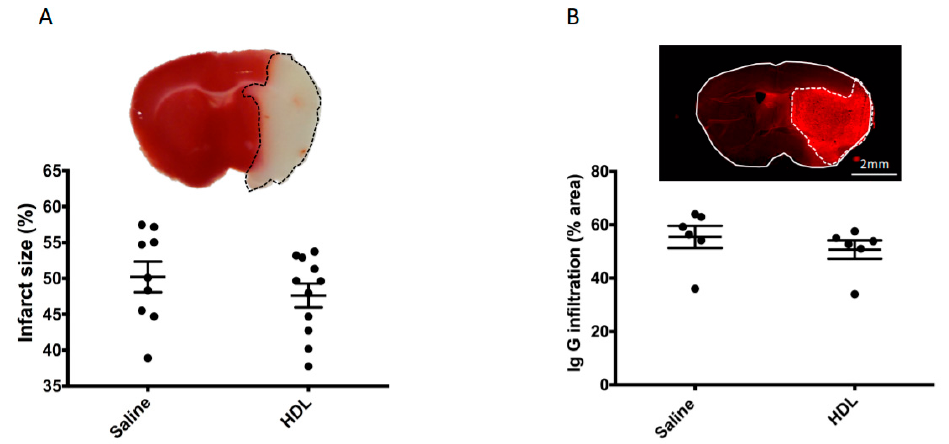
Figure 2. Infarct size and blood–brain barrier leakage. ( A ): Coronal brain sections stained with TTC. The red zone corresponds to the healthy brain region, whereas the white zone represents the infarcted area. No statistical difference was observed between saline- and HDL-treated mice (Saline: n = 9, HDL n = 11). ( B ): Coronal brain sections stained by with an antibody against immunoglobulins G (IgG) (red). The bright red area represents the infiltration of the brain parenchyma by IgG in the infarcted area. No statistical difference was observed between saline- and HDL-treated mice (Saline: n = 6, HDL n = 6).